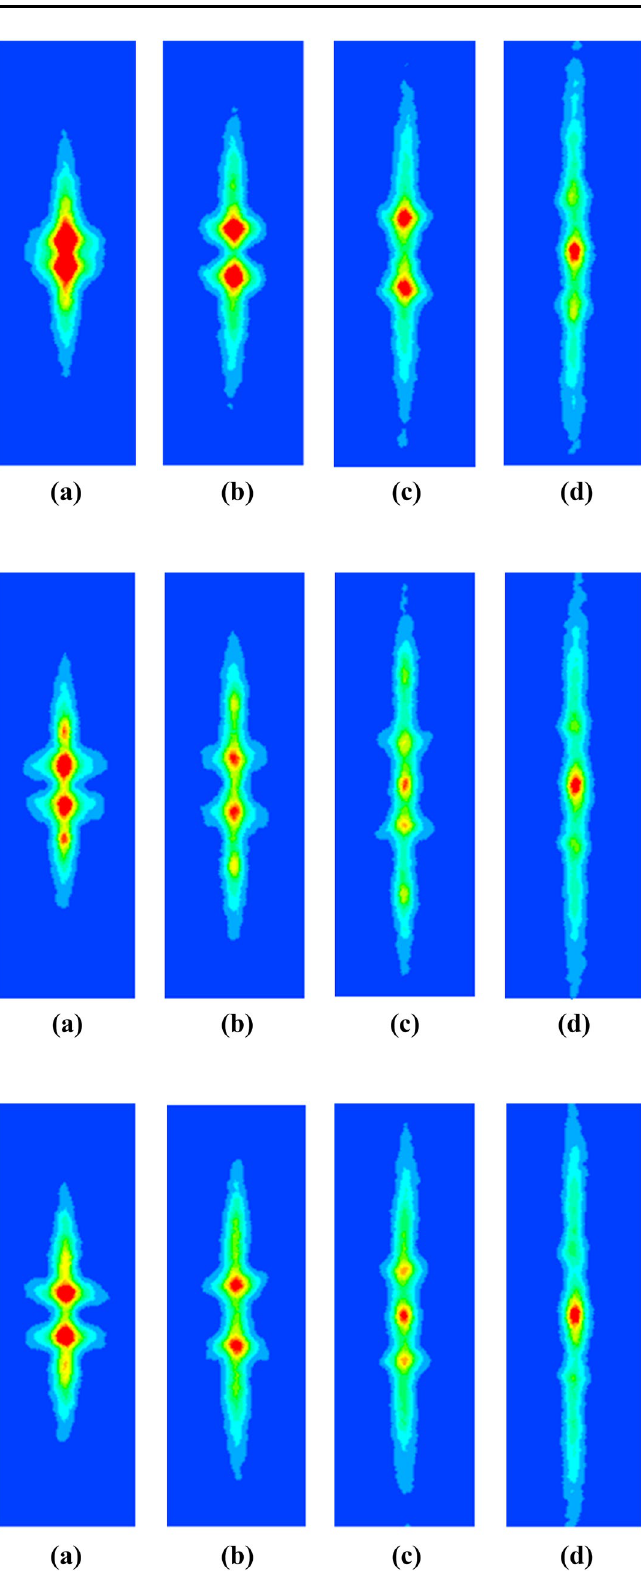
Fig. 9 Coating thickness contours for different θ